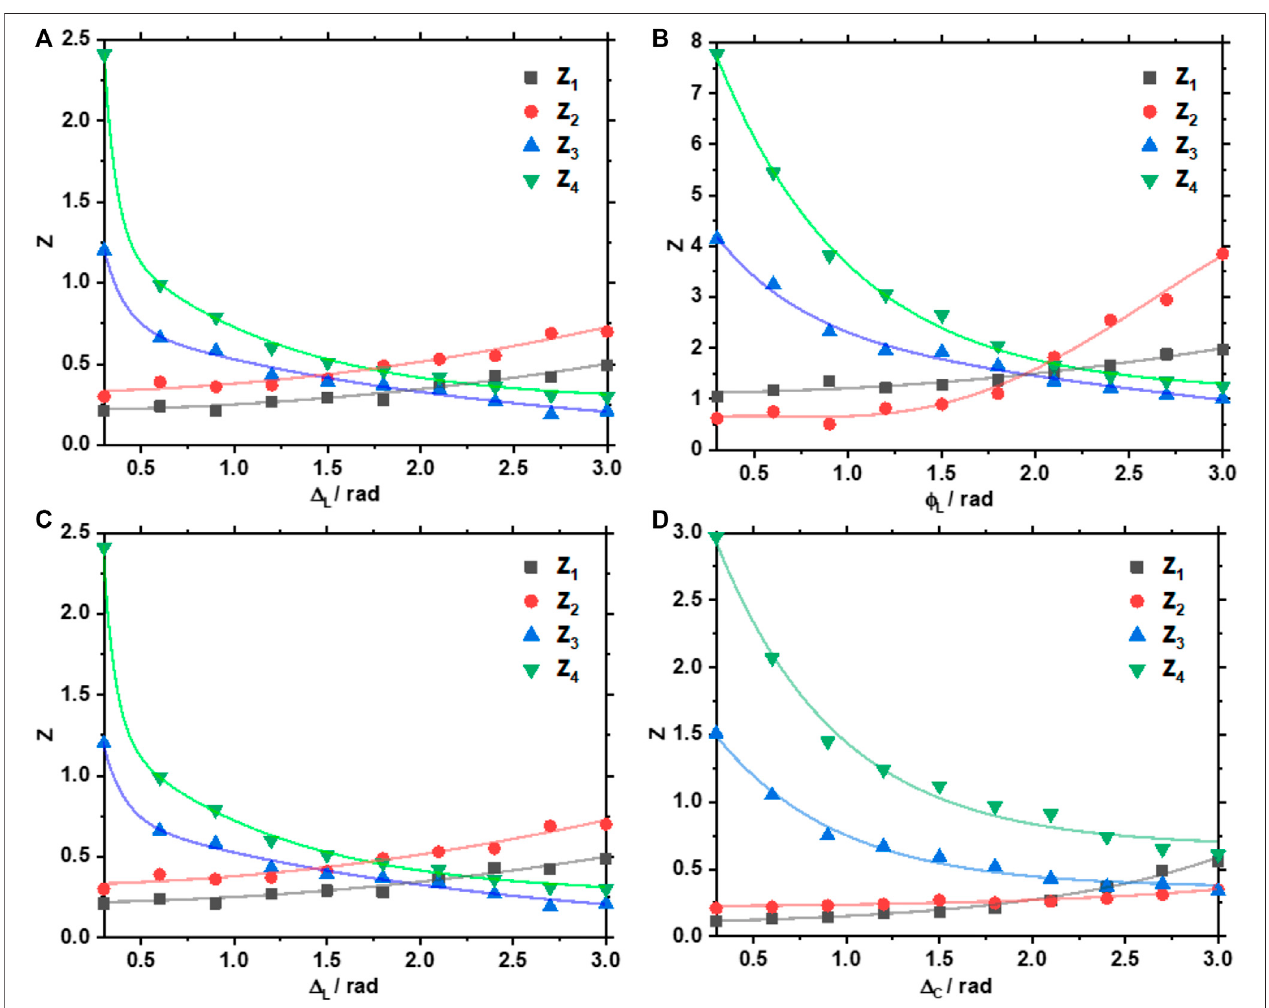
FIGURE 7 | Phase dependences of the magnitude of the fi rst to fourth statistical moments order characterising the distributions of (A) Φ L (B) Δ L , (C) Φ C (D) Δ C of the partially depolarising ( τ (cid:1) 1 . 02) myocardium histological section.